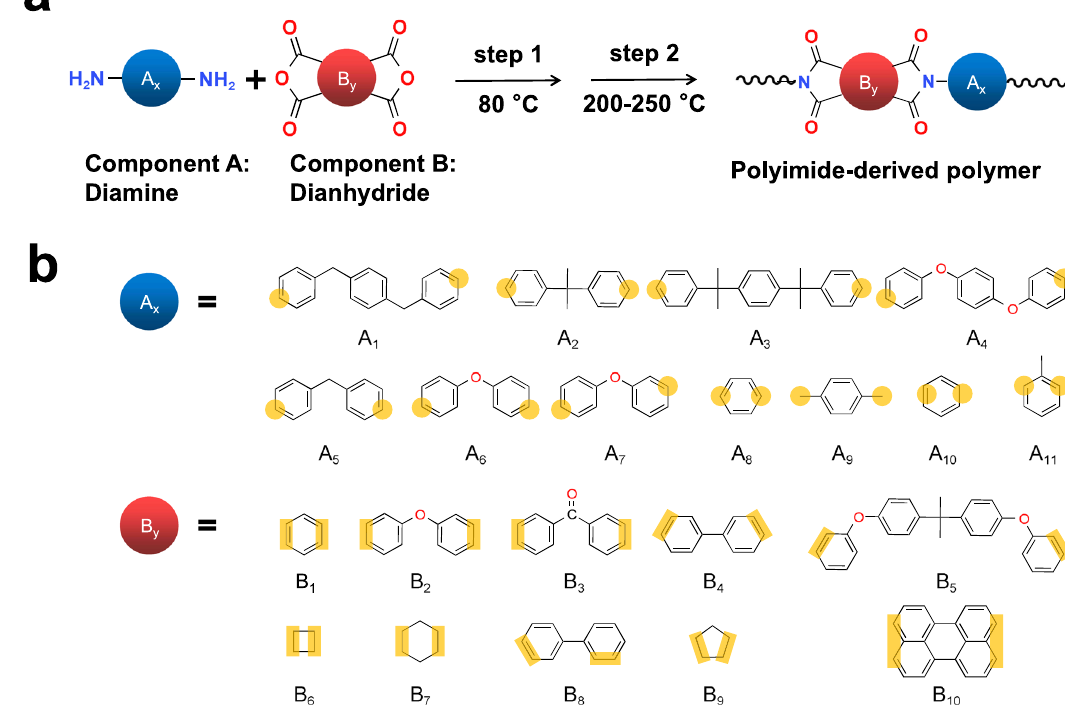
Fig. 1 | Design of polyimide-derived high-temperature polymer dielectrics. a The schematic diagram for the synthesis route of polyimide-derived polymer dielectrics. These polymersare formedby condensation ofthe diamine monomer